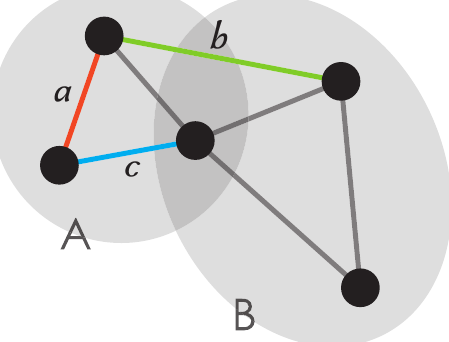
Figure 1. Ambiguous edges between two communities. This problem can be solved by appending definitions for the ambiguous edges in overlapping communities. A possible solution is that for such an ambiguous edge, it is counted as 0.5 intra-community edges and 0.5 inter-community edges. However, such a solution is not reasonable in some more complicated cases. Consider edges m and n in